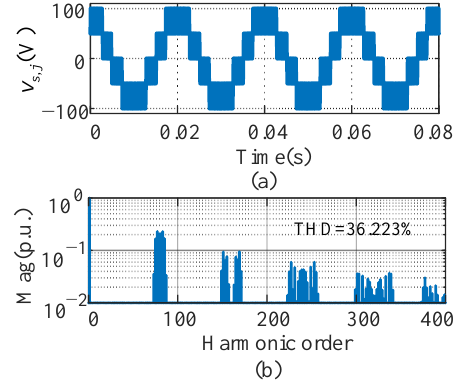
Figure 13. Theoretical output voltage of PSC5. ( a ) Waveform of equivalent output-phase voltage; ( b ) FFT analysis.